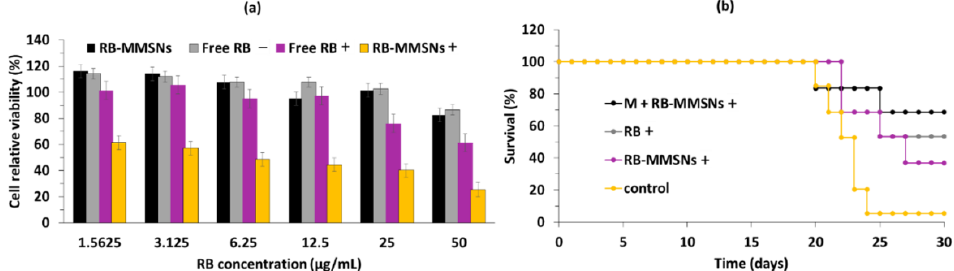
Figure 24. Preparation of the synthesis of the core–shell RB-MMSNs. Adapted from Zhan et al. [56]. The size of the MMSNs was 190 nm. The loading efficiency of RB in MMSNs was about 35.74%. In vitro experiments were performed on B16 cells. The best photototoxicity (i.e., with a 75% reduction in cell viability) was obtained after incubation of cells with 3 min) (Figure 25a). In vivo experiments were performed on C57BL/6J xenograft mice.